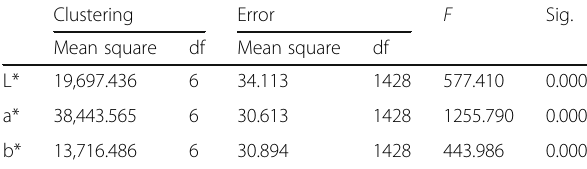
Table 3 ANOVA of L*, a*, and b* of GemDialogue color zones Clustering Error F